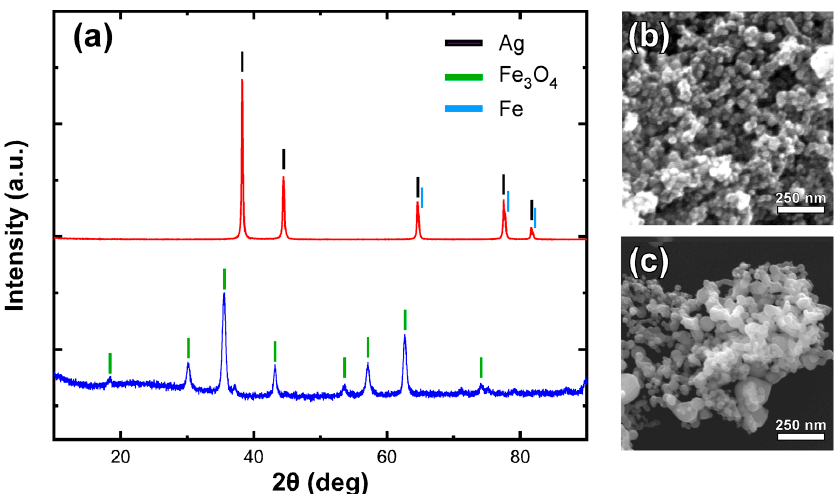
Figure 1. XRD diagram (Intensity versus 2theta angle) of used Fe 3 O 4 or Ag/Fe nanoparticles ( a ), and corresponding FE-SEM observation images for Fe 3 O 4 ( b ) and Ag/Fe nanoparticles ( c ).